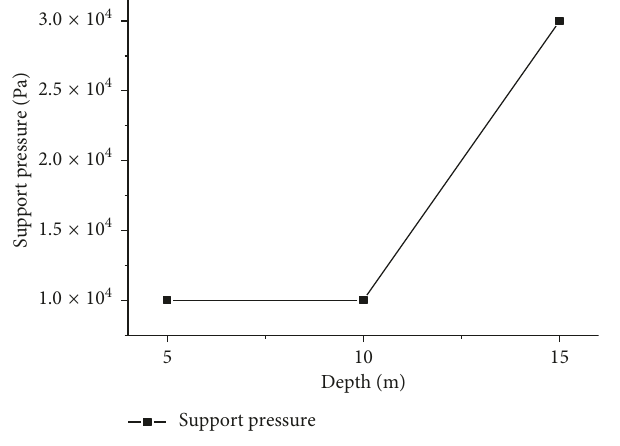
Figure 23: Ideal minimum support force.